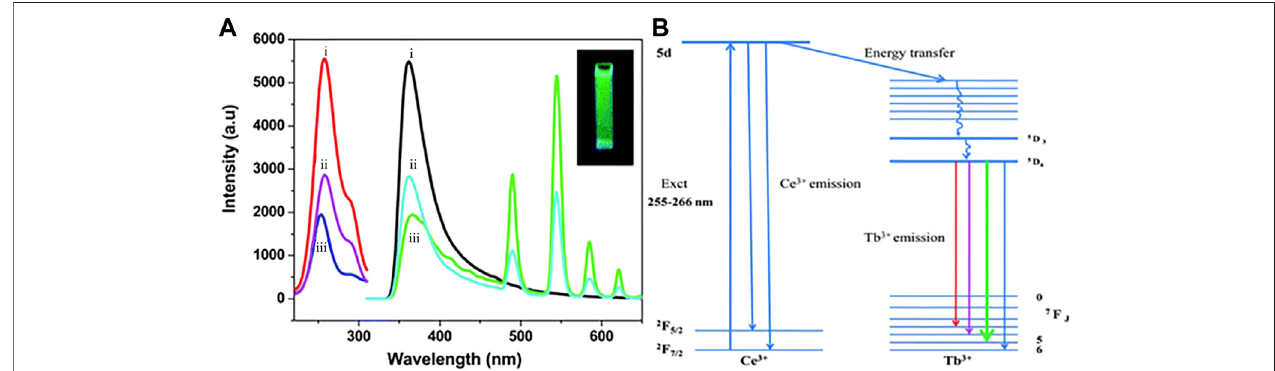
FIGURE 2 | Morphology of Na(Y1.5Na0.5)F6:Ce. (A) Low magni fi cation TEM images of 75 C dried Na(Y1.5Na0.5)F6:Ce (1) doped nanorods, (B) 75 C dried sonicated Na(Y1.5Na0.5)F6:Ce (1) doped nanoparticles, (C) core-shell NaYF4:Ce (1)/Tb nanoparticles. (D) Schematic diagram of morphology change (Ghosh et al., 2010).